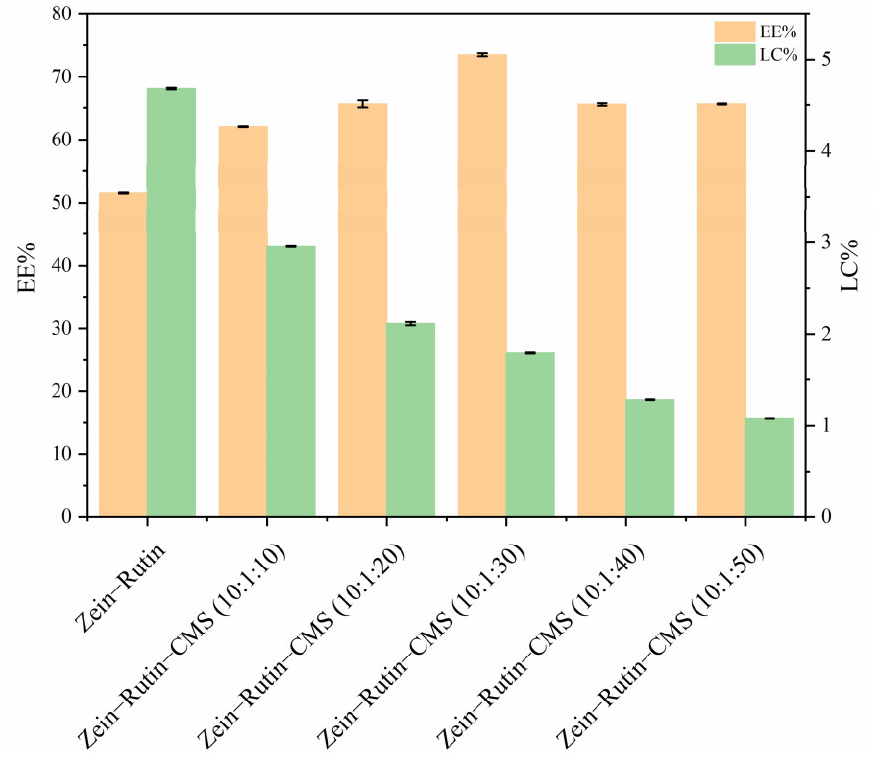
Figure 7. EE and LC of zein–RT nanoparticles and zein–RT–CMS nanoparticles.